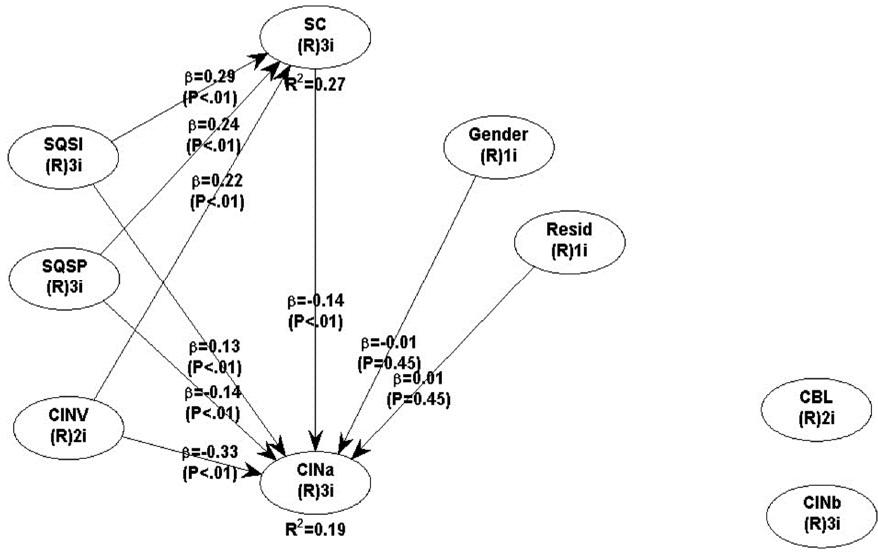
Figure A2. The second structural equation model—innovativeness interest (CIN a ) is the outcome variable.